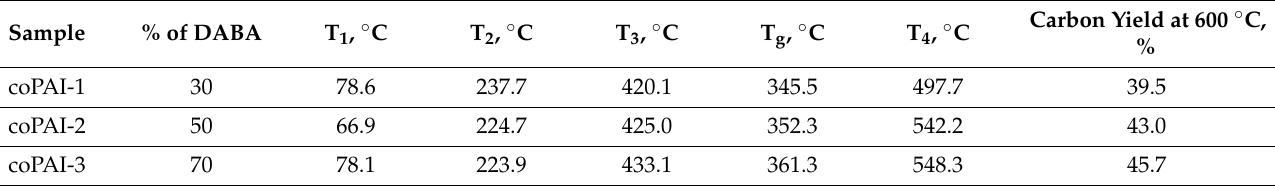
Table 2. Thermal properties of coPAIs